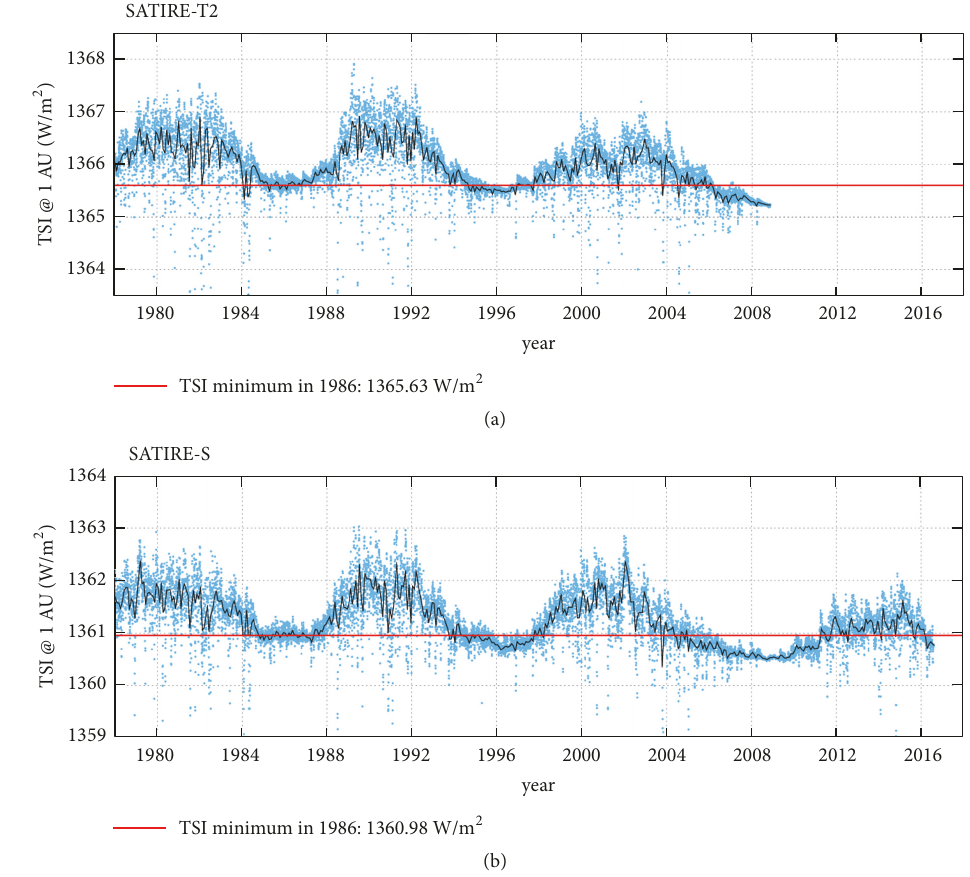
Figure 5: (a) SATIRE-T2 TSI proxy reconstruction [15]. (b) SATIRE-S TSI proxy reconstruction [16]. Daily values (blue), monthly mean